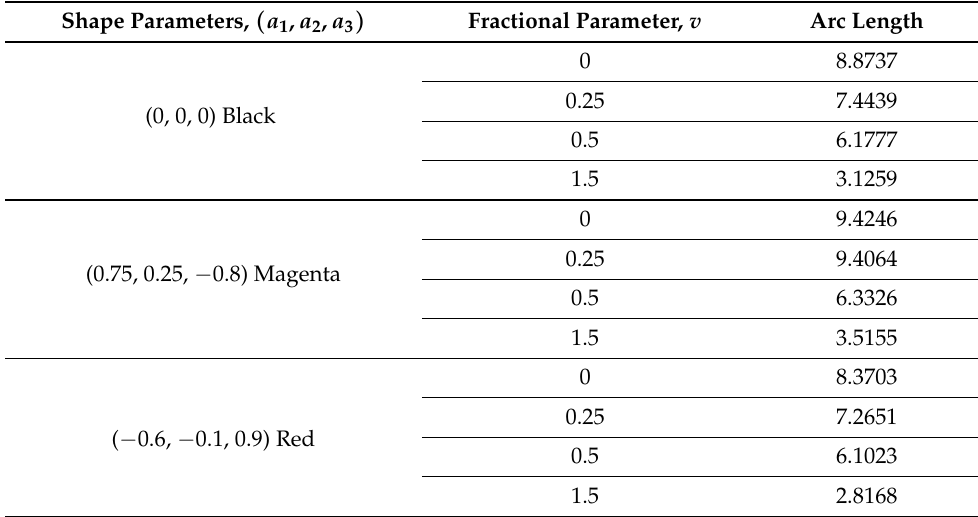
Table 1. The numerical value of arc length for cubic fractional Bézier